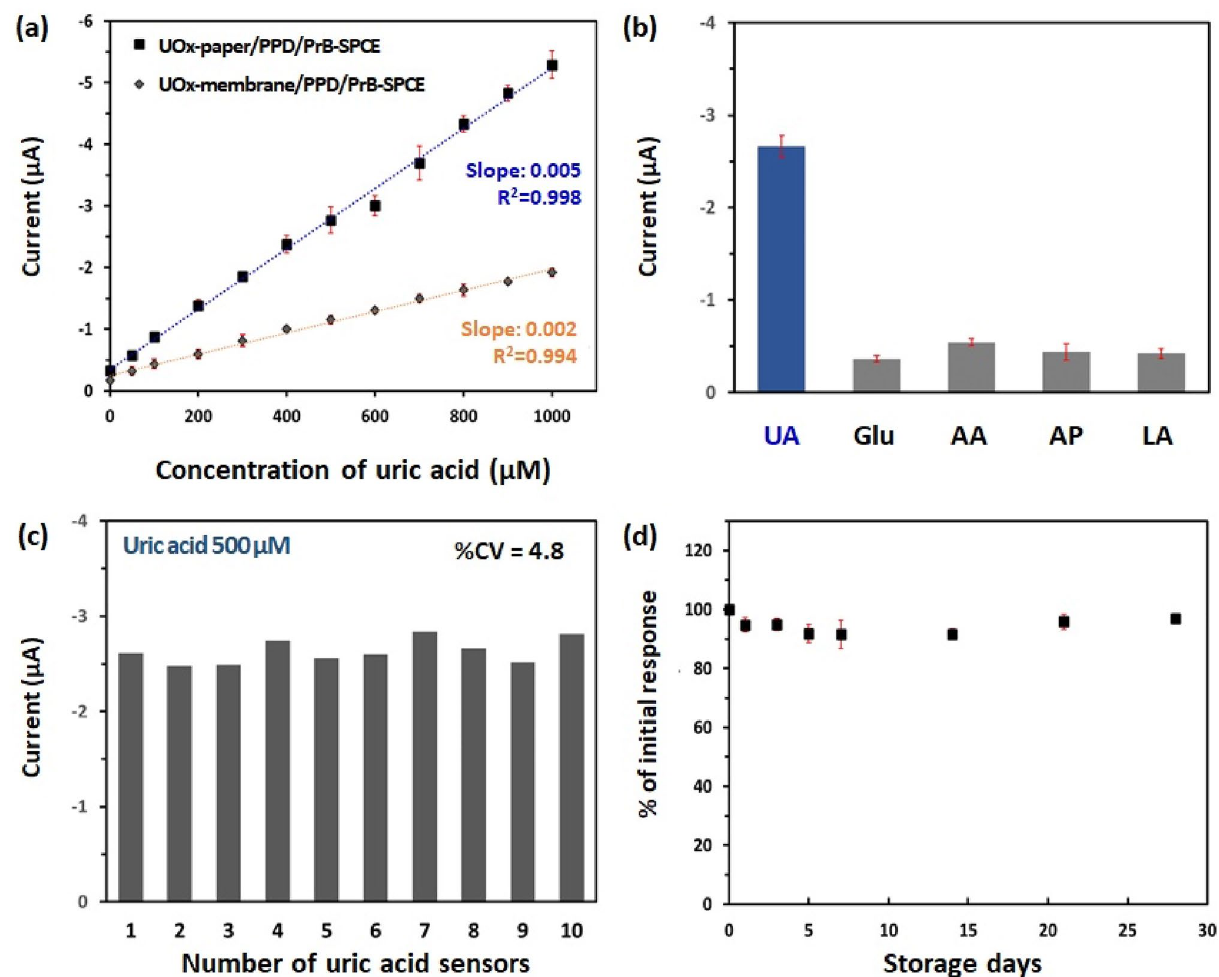
Figure 3. ( a ) The calibration curve of the cathodic current vs. UA concentration in the comparison of UOx- paper/PPD/PrB-SPCE and UOx-membrane/PPD/PrB-SPCE at − 0.1 V (vs. Ag pseudo-reference electrode), respectively. ( b ) The current response to 500 μM UA of UOx-paper/PPD/PrB-SPCE at − 0.1 V (vs. Ag pseudo- reference electrode) compared with response to common electroactive physiological interferences including